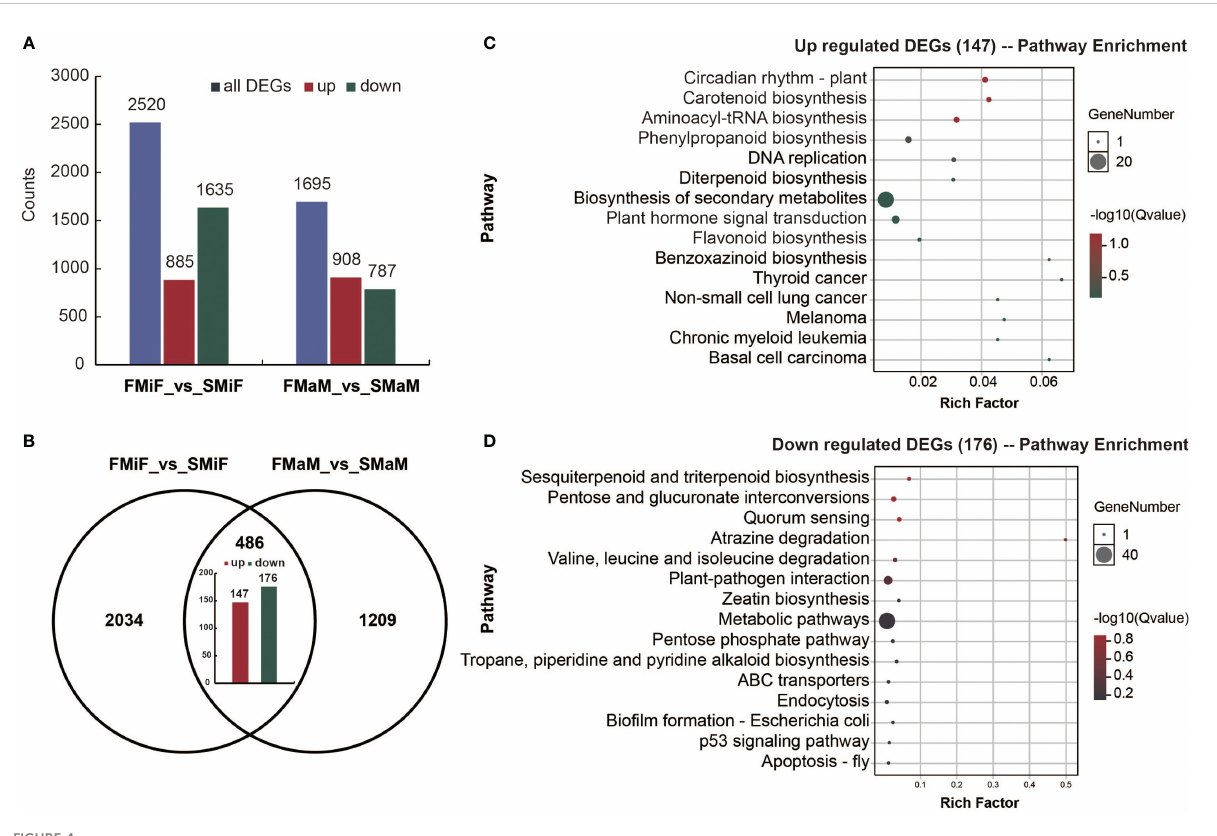
FIGURE 4 Transcriptome co-upregulation and co-downregulation analysis of secondary fl owers compared with fi rst fl owers. (A) The statistical analysis of total, upregulated and downregulated DEGs in different comparison groups. (B) Venn diagram of DEGs obtained from FMiF _vs_SMiF and FMaM_vs_SMaM. (C) KEGG enrichment analysis 147 co-upregulated DEGs. (D) KEGG enrichment analysis of 176 co-downregulated